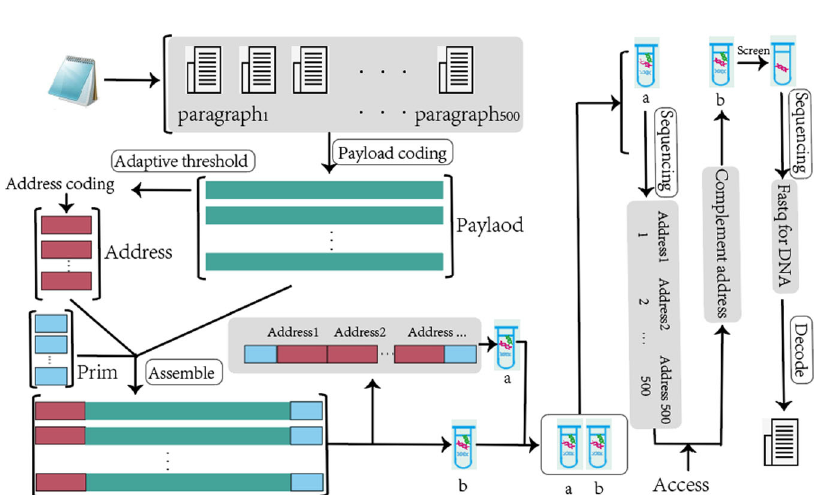
Fig. 9 Classi fi cation and overlap of coding